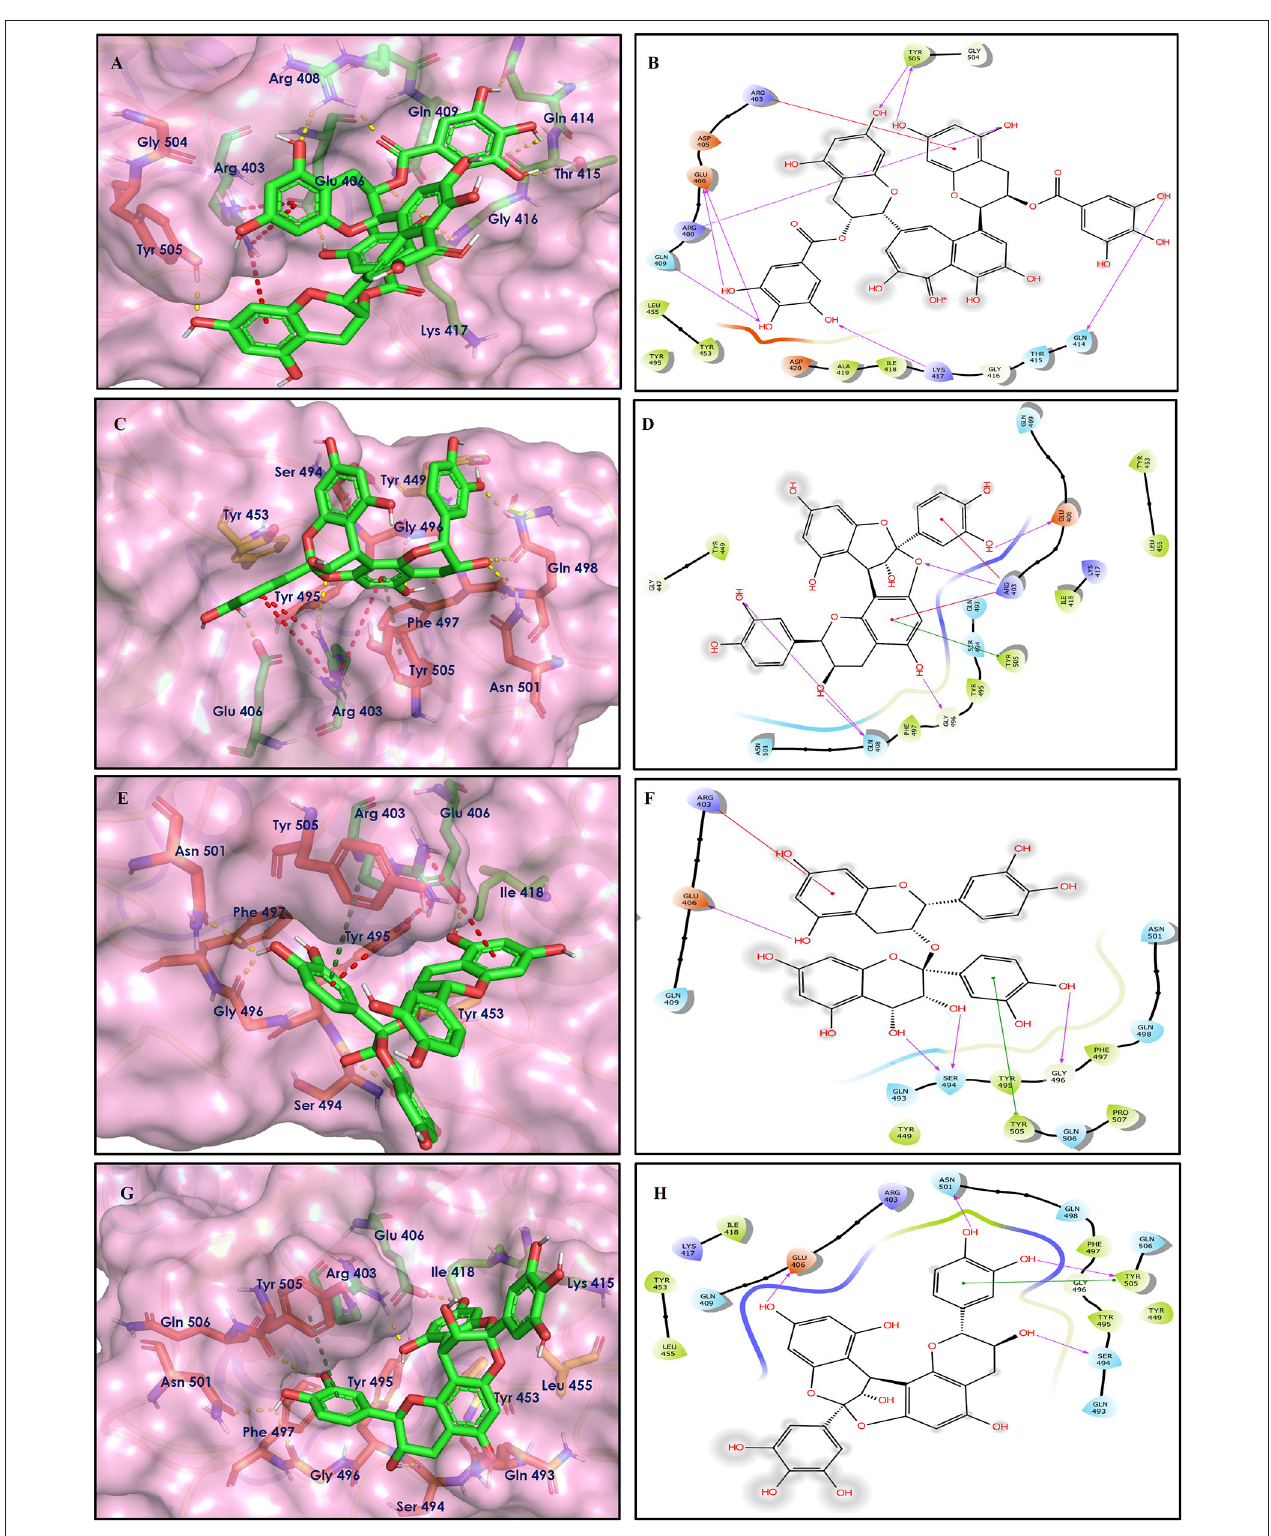
FIGURE 9 | Docking interactions of compounds (45, 11, 9, 5 : A–H) in the active sites of Spike RBD. (A,C,E,G) 3D-binding mode of compounds 45 , 11, 9 , and 5 with Spike RBD active site, respectively. Ligands are shown as green sticks, Spike RBD residues are shown as atom type color sticks, hydrogen bonds formed between ligands and receptor are depicted as yellow dotted lines, π - π stacking interaction as green dotted lines and π -cation interaction as red dotted lines. (B,D,F,G) 2D-ligand interaction diagram of compounds 45 , 11, 9 , and 5 with Spike RBD active site, respectively.